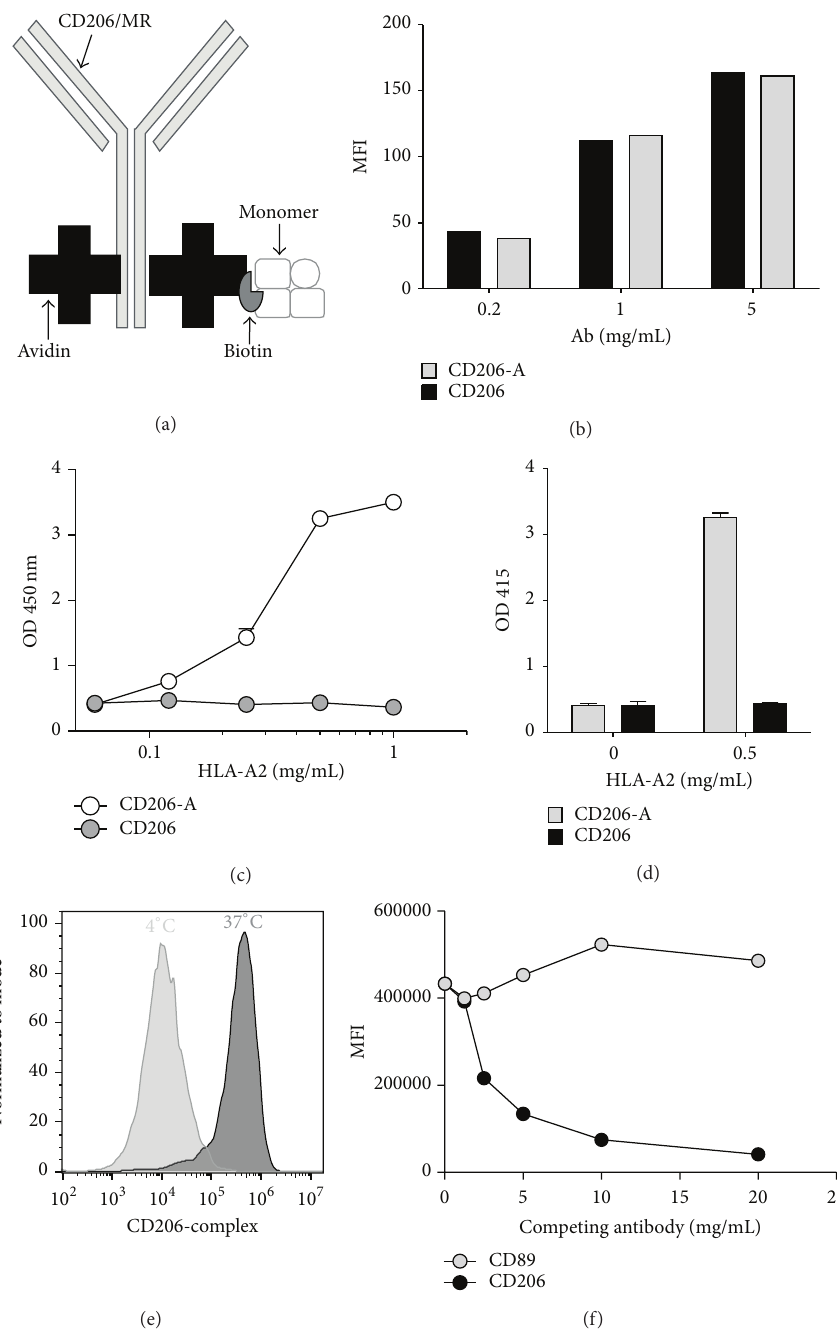
Figure 4: CD206-HLA-A2 complexes are efficiently bound and taken up by moDCs through CD206 receptor mediated endocytosis. (a) Diagrammatic representation of the targeting Ab. Avidin groups conjugated and their position depicted in the diagram are arbitrarily chosen. (b) moDCs were stained with the conjugated (CD206-A) or nonconjugated (CD206) Ab at different concentrations. Indicated is the mean florescence intensity (MFI). (c) Formation of the biotinylated HLA-A2/CD206-A immune-complex was investigated by setting up a sandwich ELISA system as explained in Materials and Methods. Briefly, the CD206/CD206-A was coated onto a 96-well plate, biotinylated HLA-A2 was added at different concentrations, and subsequently an anti-HLA-A2 antibody and a peroxidase targeting the secondary antibody were added. ABTS was used as substrate. (d) Cross-reactivity of the antibodies was ruled out by coating CD206-A (grey bars) or CD206 (dark bars) in the presence or absence of HLA-A2 and incubation of the Ab as depicted in C. CD206-A (grey bars) or CD206 (dark bars) were coated with or without HLA-A2. (e) To demonstrate that CD206-targeted complexes were taken up via CD206, we created complexes of APC- labeled streptavidine, biotinylated HLA-A2 monomer, and CD206 (CD206-A2-strep) at a molecular ratio of, respectively, 1: 2: 2. Uptake of CD206-A2-strep was determined by culturing moDC with the complex for 24 h at 4 ∘ C (light grey) or 37 ∘ C (dark grey). (f) To determine CD206-specific uptake, moDCs were cultured with the CD206-A2-strep complex, with competing MR/CD206 or irrelevant CD89 Ab. After overnight incubation, the APC fluorescence intensity was assessed by flow cytometry. Shown is one representative